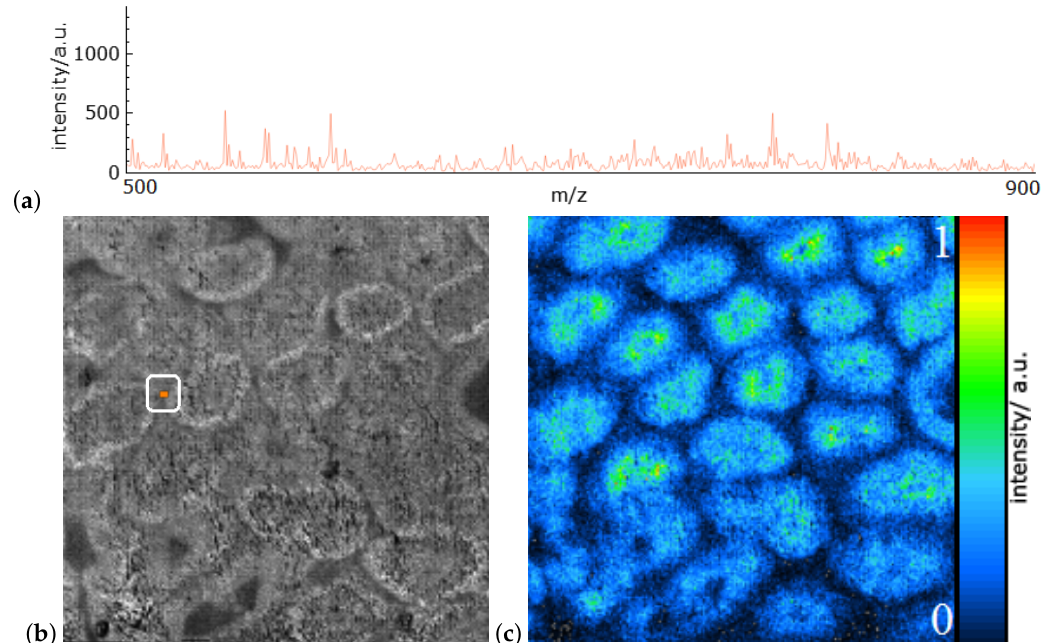
Figure 1. ( a ) Mass spectrum from the data set of rat testis with the 500 most intensive peaks depicted as intensities over m / z -ratios for a selected pixel indicated in ( b ). Grayscale values of average peak intensity over all 500 peaks for each pixel ( b ). Color-coded spatial intensity distribution in image-space for selected peak with m / z -ratio 846.5753 ( c ). Data was taken from